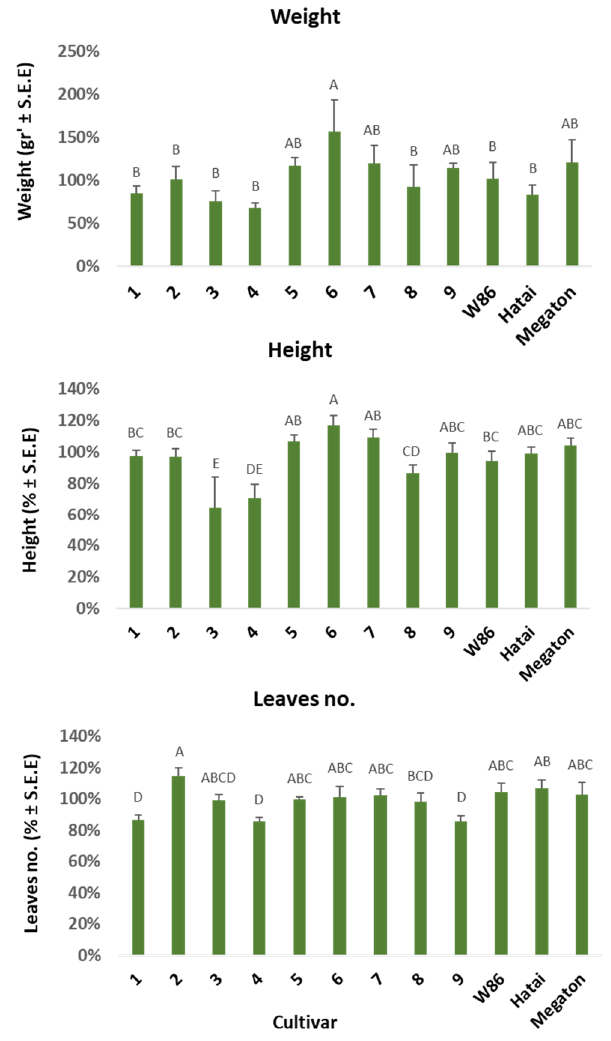
Figure 4. Plants’ growth parameters evaluation 50 days after sowing. The experiment is described in Figure 3. Values represent the average difference (%) of the plants that grew on naturally infected commercial field soil treated with complementary inoculation compared to the control (the same soil without additional inoculation). Weight —wet biomass. Height —length of aboveground plant parts. Leaves no .—the plants’ phenological stage. Vertical upper bars represent the standard error of the mean of five repeats (pots). Values represent percentages different from the control treatment in the same cultivar. Different letters above the bars represent a significant difference ( p < 0.05) in an analysis of variance (ANOVA)